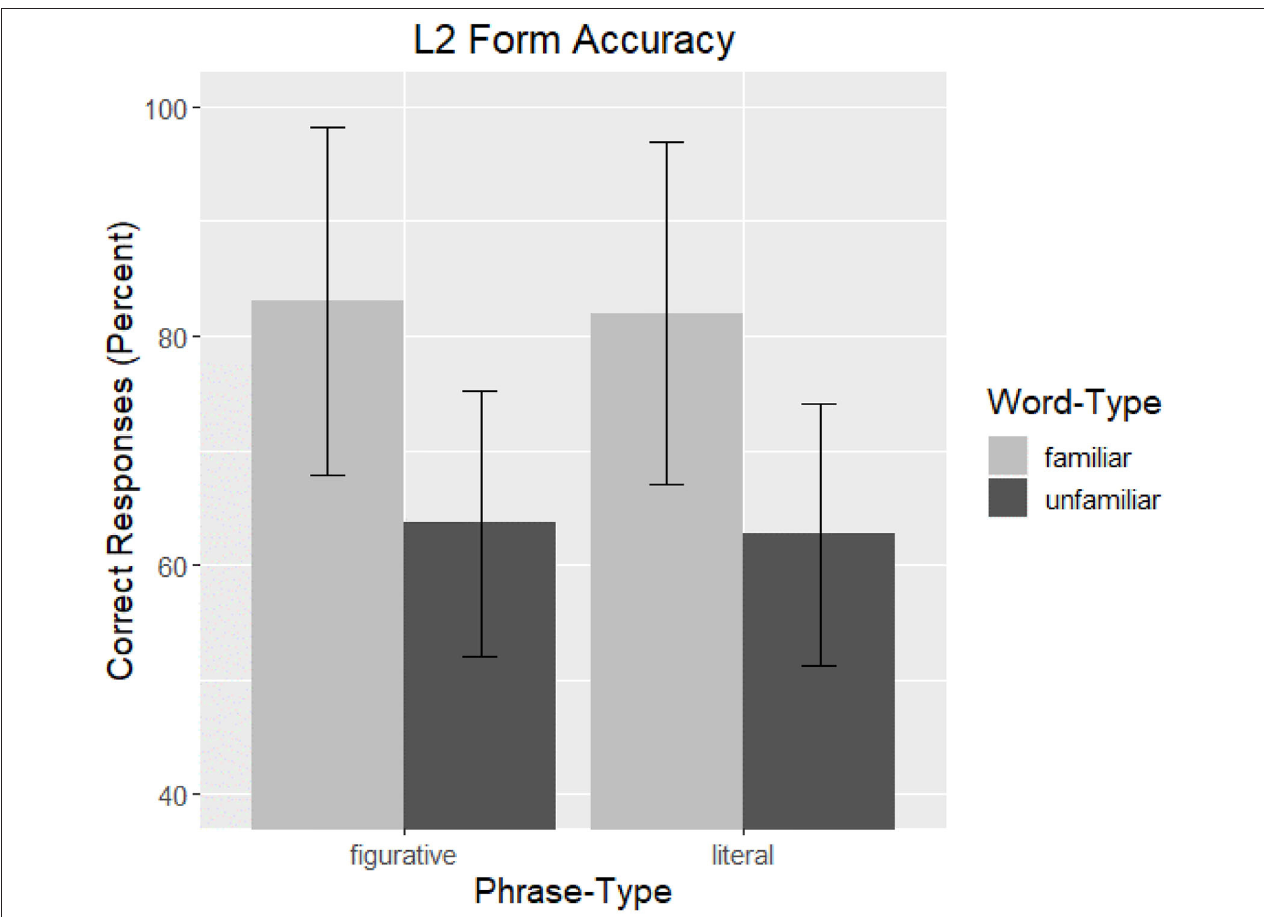
FIGURE 2 | L2 Form Accuracy. The overall correctness of participant responses to form recognition are graphed as a function of Phrase-Type by Word-Type . Familiar words are represented by light gray and unfamiliar words by dark gray, and bars are the standard error of the mean.